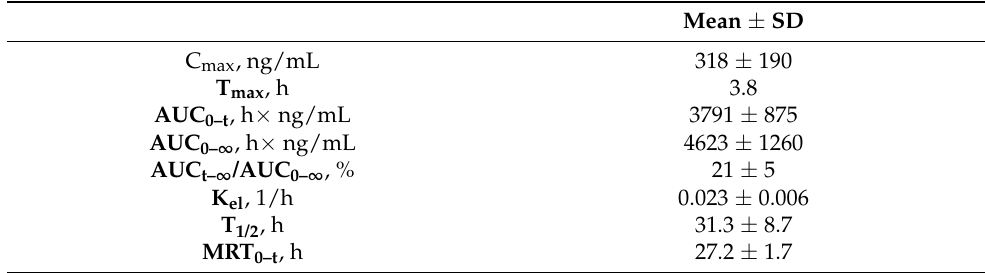
Table 2. Pharmacokinetic parameters of conjugate PSMA-Abi estimated in rats after single peroral administration at a dose 1000 mg/kg as 1% starch suspension